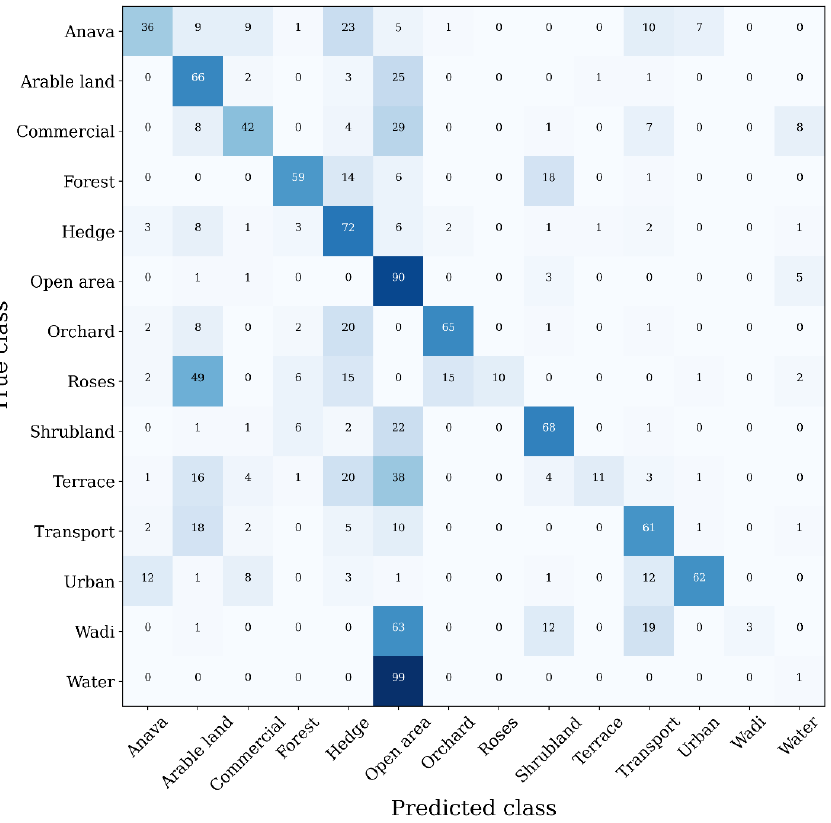
Figure 12. Confusion matrix of the predicted vs. the true LULC classes for the Sagalassos 1981 test set. Values are given as percentages over the true